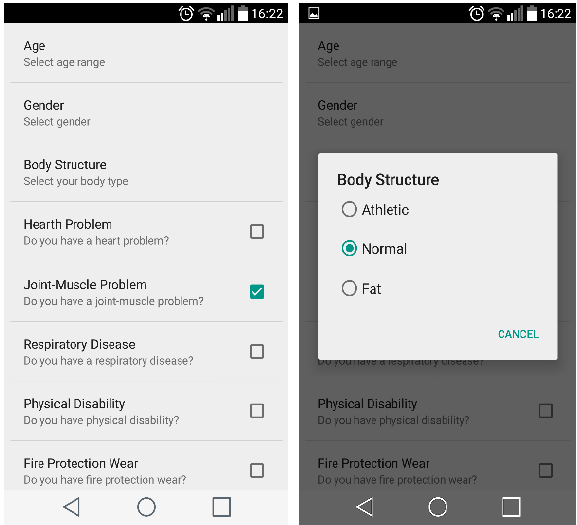
Figure 2. Settings screen of the mobile application.